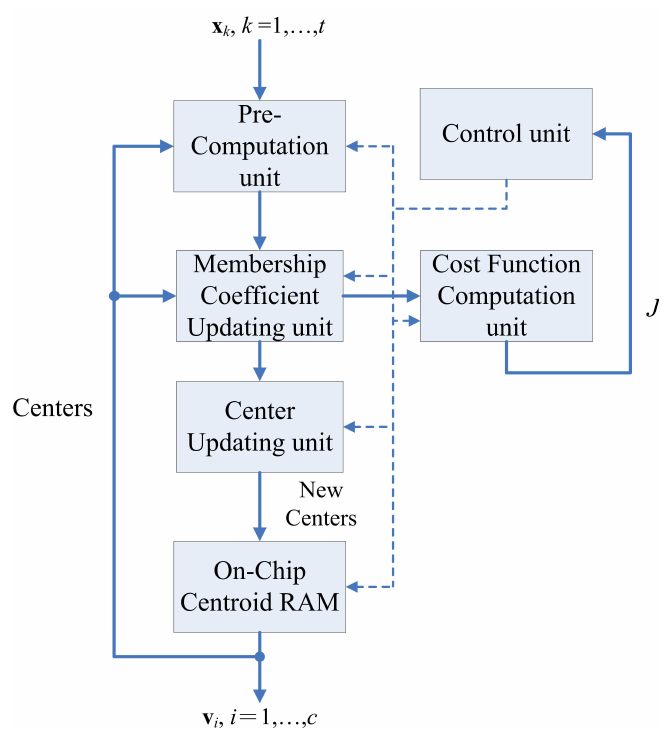
Figure 3. The FCM